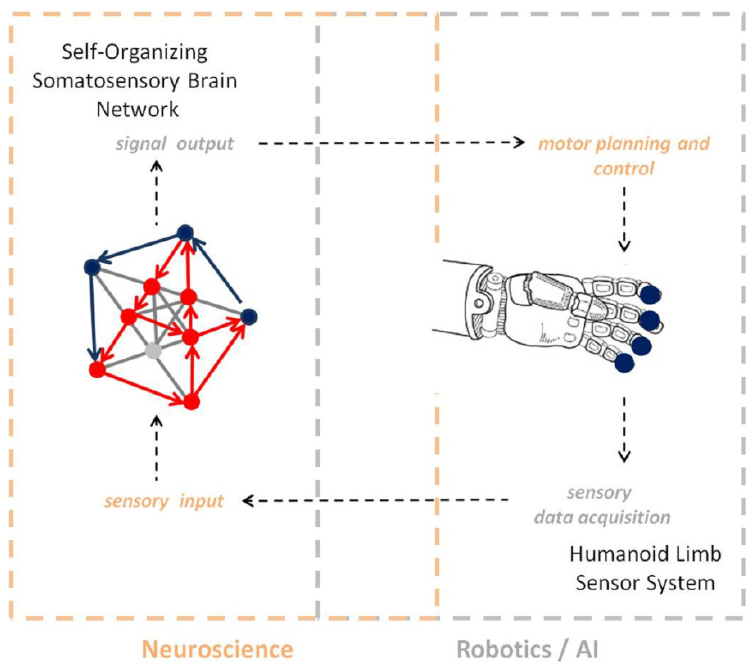
Figure 6. Conceptual diagram illustrating a “closed-loop” link between systems neuroscience and robotics / AI.